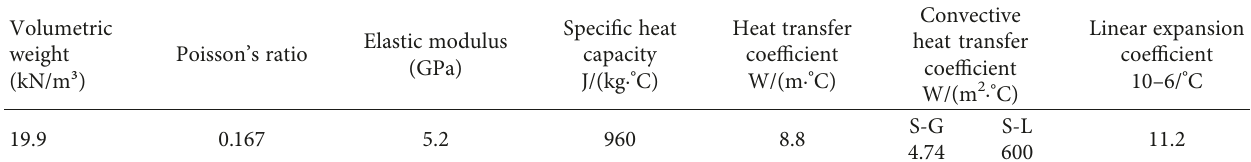
Table 2: Physical and thermodynamic parameters of the model.